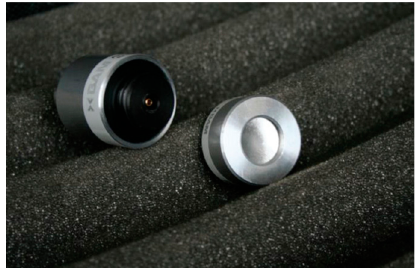
Figure 17. Focusing transducer based on cellular polypropylene with an electric matching unit shown in the background for air-coupled ultrasonic testing. Reproduced with permission from Reference [151], Copyright AIP, 2016.